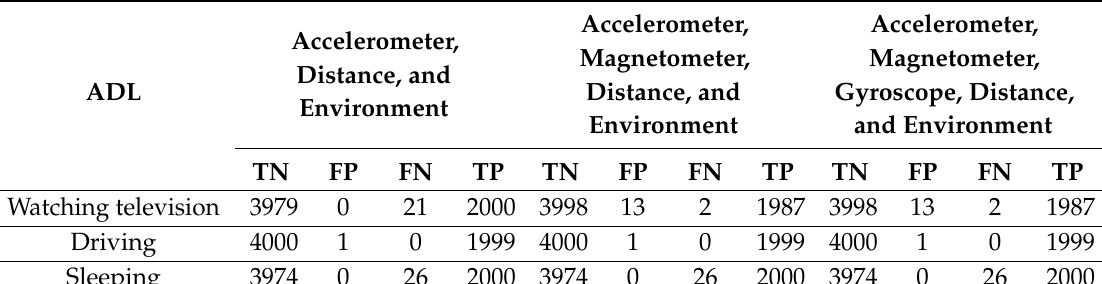
Table 16. Confusion matrix values of the recognition of activities without motion using the AdaBoost with the decision stump method implemented with Weka software for motion, magnetic, and location sensors after the recognition of the environment (TP = True Positive; TN = True Negative; FP = False Positive; FN = False Negative)